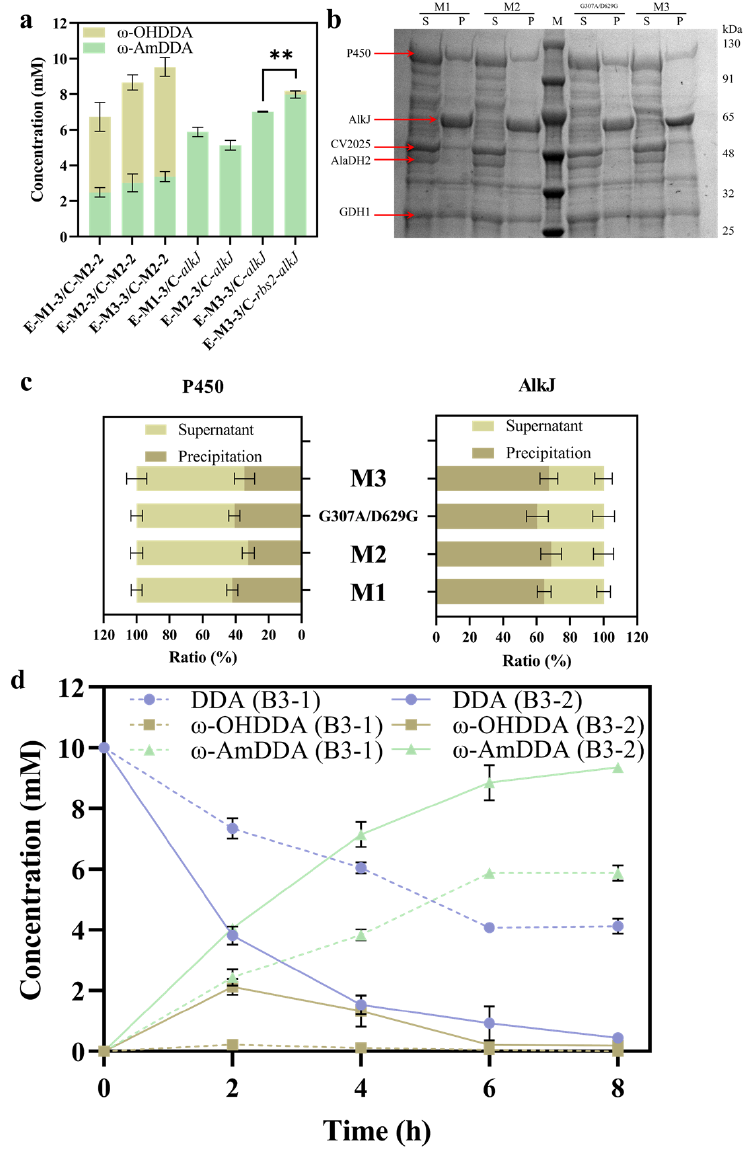
Figure 7. Construction of the ω -AmDDA synthesis pathway in E. coli . ( a ) ω -AmDDA production in the P1-1 strain expressing M1, M2 and M3 together with BsADH or AlkJ. The P450 in E-M1-3 was M1, while those in E-M2-3 and E-M3-3 were the P450 mutants M2 and M3, respectively. Statistical analysis was performed by an unpaired two-tailed t-test. ** p < 0.01. ( b ) Expression of P450, AlkJ, CV2025, AlaDH2 and GDH1. Lane M, marker; lane S, supernatant; lane P, precipitation; AlkJ, alcohol dehydrogenase. ( c ) Expression analysis of P450 mutants and AlkJ. SDS-PAGE protein electro- phoresis results were analyzed by ImageJ software to calculate the proportions of P450 and AlkJ in the supernatant and the precipitation of M1, M2, G307A/D629G (cyp153a-ncp G307A/D629G ) and M3, respectively. ( d ) Biotransformation of DDA to ω -AmDDA by B3-1 (P1-1 (E-M1-3/C- alkJ )) and B3-2 (P1-1, Δ yfeX - T10 :: P tac -hemB (E-M3-3/C- rbs2 - alkJ )). The reaction was performed with 50 g cww/L of resting cells in sodium phosphate buffer (100 mM, pH 8.0) containing 1% ( w / v ) D-glucose, NH 3 ·H 2 O/NH 4 Cl (200 mM, NH 3 ·H 2 O:NH 4 Cl = 1:10) and 10.0 mM DDA (2% DMSO). The tempera- ture was maintained at 30°C, the agitation speed was maintained at 220 rpm, the pH was maintained at 7.5–8.0 and the concentration of D-glucose was maintained at 0.5–1% ( w / v ) throughout the bio- transformation process. All biotransformation reactions were performed in triplicate, and error bars represent standard deviations. In order to further improve the production of ω -AmDDA, we introduced the above- mentioned plasmid into the P1-1, Δ yfeX -T10:: P tac -hemB-T 1 strain to construct the B3-2 (P1- 1, Δ yfeX -T10:: P tac -hemB-T 1 (E-M3-3/C- rbs2 - alkJ )) strain. Compared with B3-1 (P1-1 (E-M1- 3/C- alkJ )), obviously more ω -OHDDA was produced within the first 2 h, while it was al- most completely converted to ω -AmDDA after 6 h of the reaction (Figure 7d). Finally, the